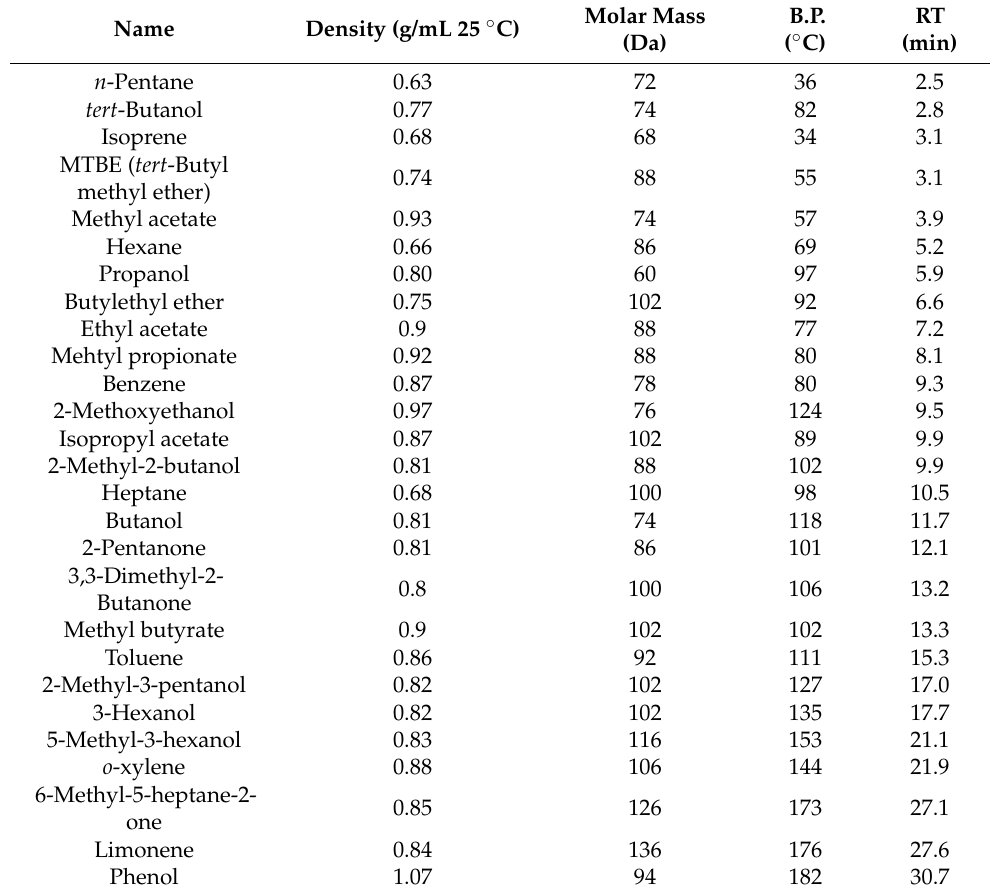
Table 1. Model analytes with their physical properties and GC retention time